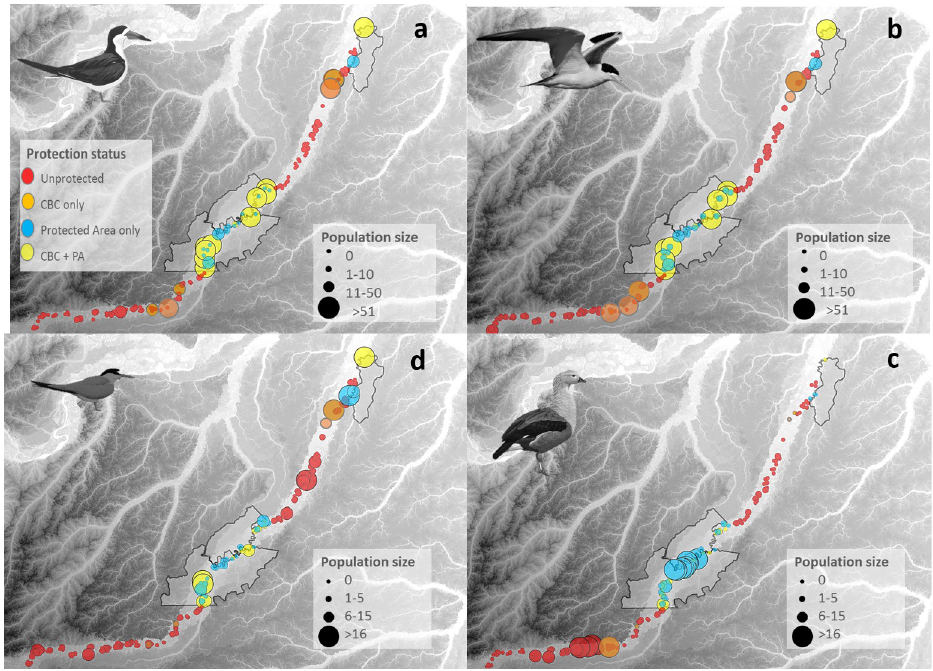
Fig 4. Distribution map showing the number of individuals of four waterbird species surveyed along ~1,600 km the Jurua´ River under different protection regimes. (A) Black Skimmers, (B) Large-Billed Terns, (C) Yellow-Billed Terns, and (D) Orinoco Geese. Symbol sizes are scaled according to census counts; color indicates beach protection status. The background elevation map of the study region illustrates height of local terrain using a color gradient from dark gray (upland) to light gray (lower terrain). Solid black lines represent the boundaries of three sustainable-use PAs. Landsat-7 image courtesy of the U.S. Geological Survey.